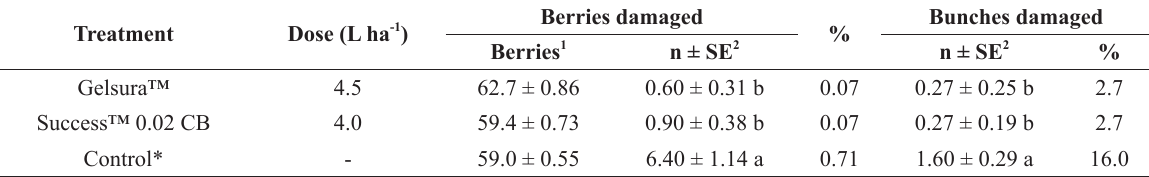
Average number (n ± standard error) and percentage (%) of berries and bunches of table grapes of the ‘Sugar Crisp’ cultivar containing damage by Ceratitis capitata over three weeks of evaluations. Casa Nova, BA (Area 1). Treatment